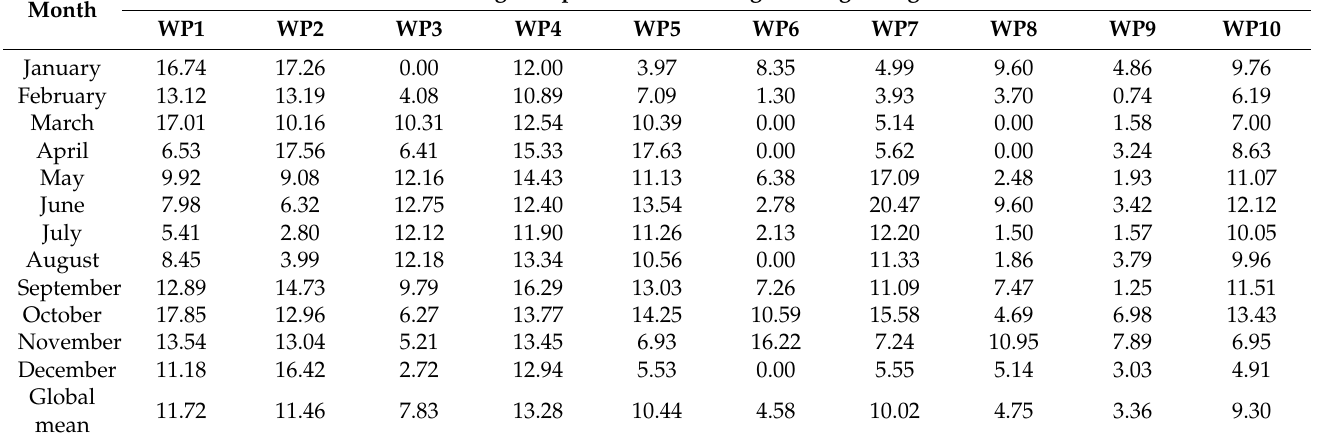
Table A4. Monthly average amplitude (kA) (observation period 2011–2020) of the recorded negative lightning strikes per wind